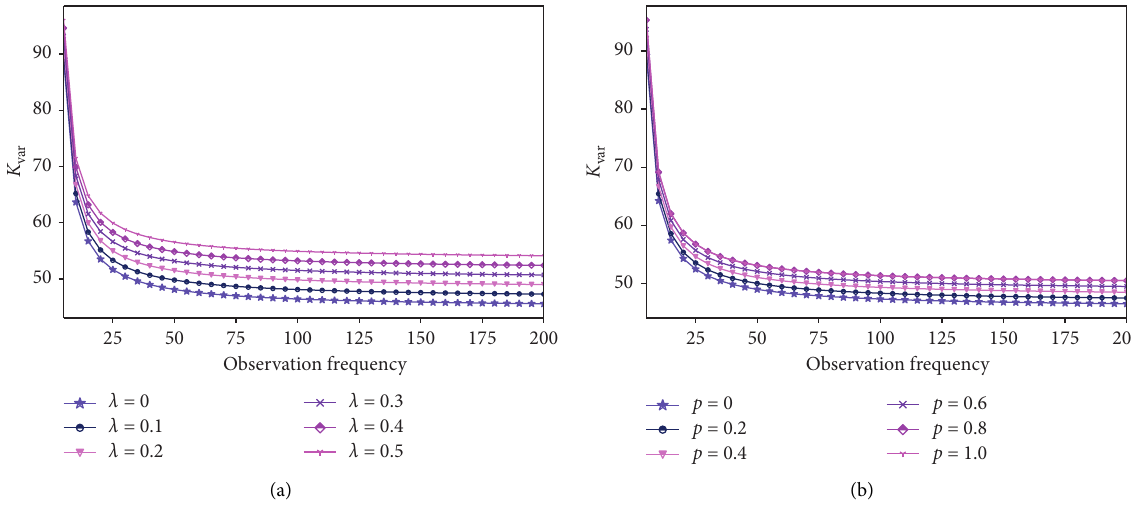
with and without regime switching. (a) Comparison of K var